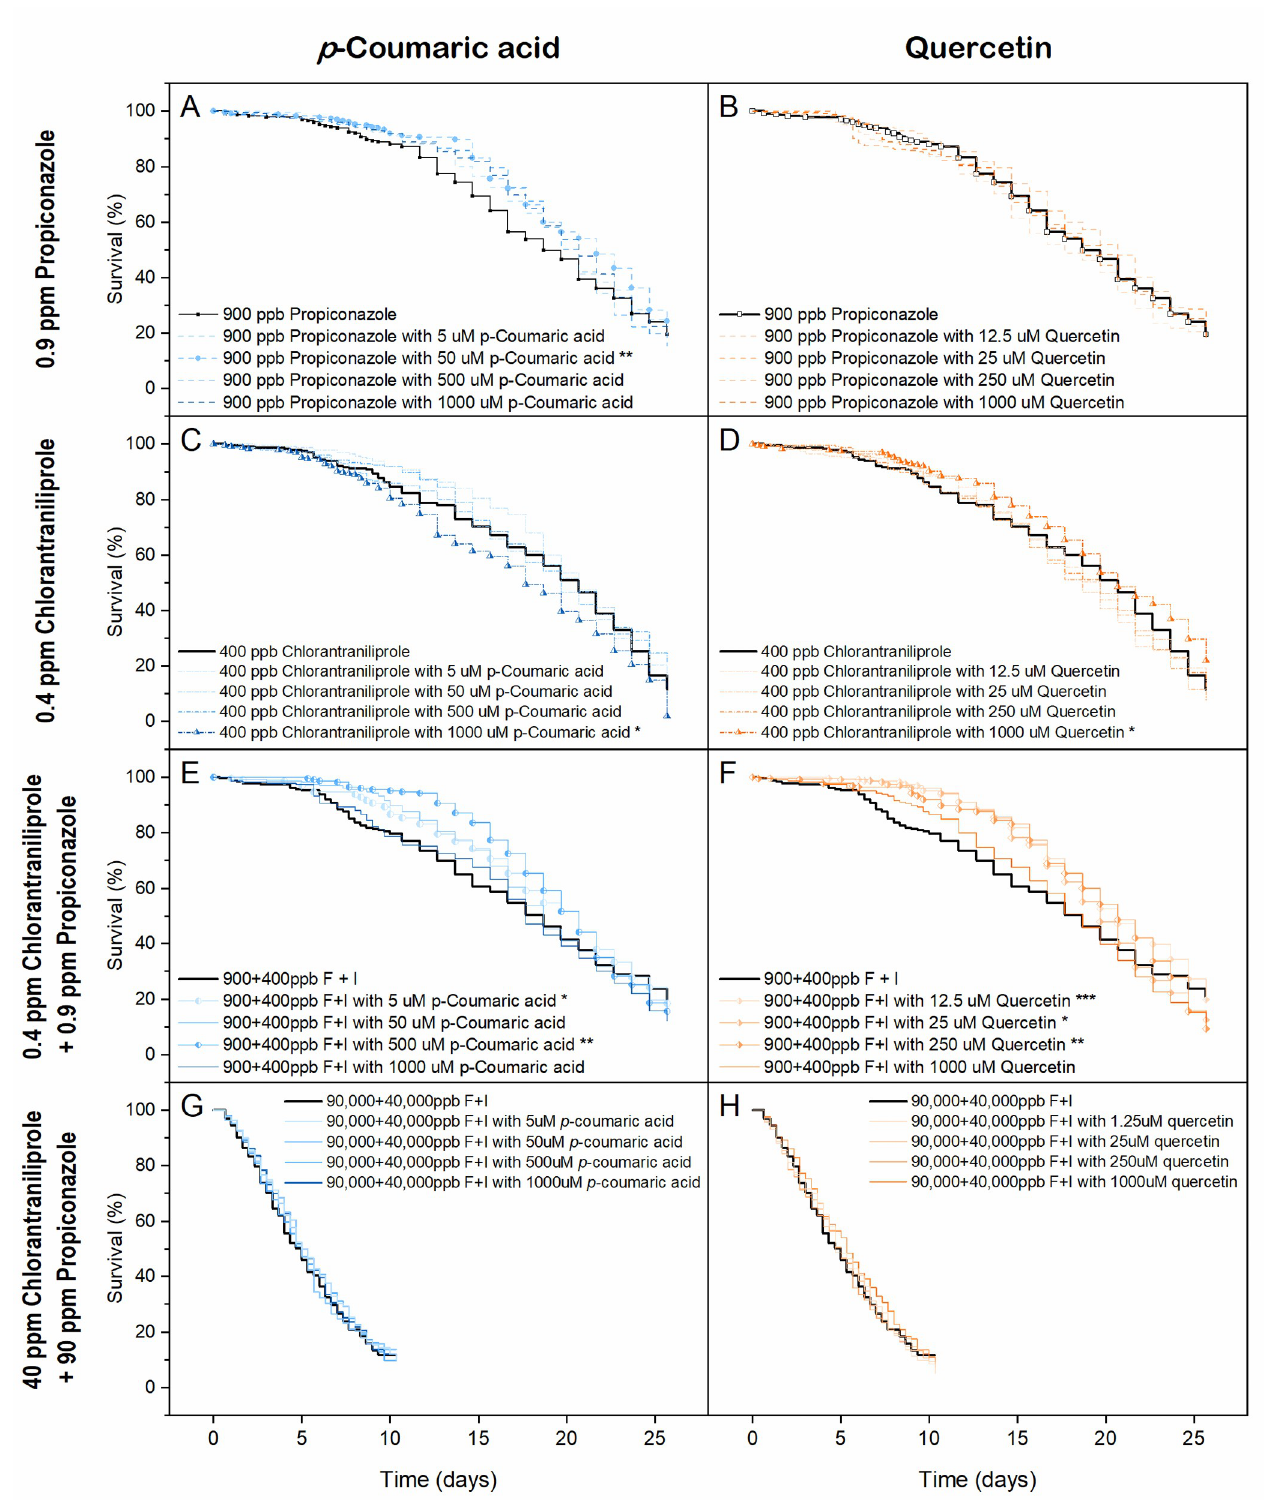
Fig 4. Kaplan–Meier survival curves of honey bees on dietary tank-mix pesticides and phytochemicals. Diet treatments included: (A) 0.9 ppm propiconazole amendment with p- coumaric acid at a range of concentrations, (B) 0.9 ppm propiconazole amendment with quercetin at a range of